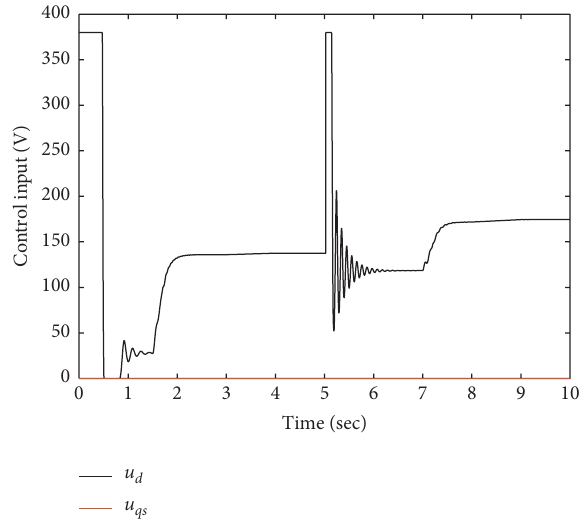
Figure 8: Evolution of optimal control inputs.